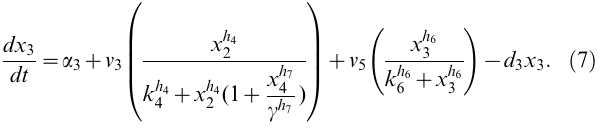
Found at: doi:10.1371/journal.pone.0008083.s002 (0.47 MB TIF) Figure S3 Continuation results for Scenario 2. Continuation results for Scenario 2 using DDE-BIFTOOL software. (A) Two parameters continuation of the Hopf bifurcation on parameters k 2 (Michealis-Menten coefficient of the HO promoter) and h 3 (Hill coefficient of the MET16 promoter). (B) Two parameters contin- uation of the Hopf bifurcation on parameters v 2 (maximal transcriptional rate of the MET16 promoter) and k 6 (Michealis- Menten coefficient of the ASH1 promoter). (C) Two parameters continuation of the Hopf bifurcation on parameters k 6 (Michealis- Menten coefficient of the ASH1 promoter) and h 3 (Hill coefficient of the MET16 promoter). (D) Two parameters continuation of the Hopf bifurcation on parameters h 3 (Hill coefficient of the MET16 promoter) and h 6 (Hill coefficient of the ASH1 promoter). (E) Tunability of the oscillations in terms of amplitude. Amplitude of x 1 (level of the CBF1 gene) continuing the periodic solution on h 3 (Hill coefficient of the MET16 promoter). (F) Tunability of the oscillations in terms of period. Period of x 1 ( CBF1 gene) continuing the periodic solution on h 3 (Hill coefficient of the MET16 promoter). Found at: doi:10.1371/journal.pone.0008083.s003 (0.30 MB TIF) Figure S4 Continuation results for Scenario 3. Continuation results for Scenario 3 using DDE-BIFTOOL software. (A) Two parameters continuation of the Hopf bifurcation on parameters k 2 (Michealis-Menten coefficient of the HO promoter) and h 3 (Hill coefficient of the MET16 promoter). (B) Two parameters continuation of the Hopf bifurcation on parameters v 2 (maximal transcriptional rate of the MET16 promoter) and k 6 (Michealis- Menten coefficient of the ASH1 promoter). (C) Two parameters continuation of the Hopf bifurcation on parameters k 6 (Michealis- Menten coefficient of the ASH1 promoter) and h 3 (Hill coefficient of the MET16 promoter). (D) Two parameters continuation of the Hopf bifurcation on parameters h 3 (Hill coefficient of the MET16 promoter) and h 6 (Hill coefficient of the ASH1 promoter). (E) Tunability of the oscillations in terms of amplitude. Amplitude of x 1 (level of the CBF1 gene) continuing the periodic solution on h 3 (Hill coefficient of the MET16 promoter). (F) Tunability of the oscillations in terms of period. Period of x 1 ( CBF1 gene) continuing the periodic solution on h 6 (Hill coefficient of the ASH1 promoter). Found at: doi:10.1371/journal.pone.0008083.s004 (0.26 MB TIF) Figure S5 Continuation results for Scenario 4. (A) Scenario 4 A. One parameter continuation of the steady state on k 1 (Michealis- Menten coefficient of the HO promoter). Two saddle-node bifurcation points (at (k 1 ; x 1 )= (0.02 0.007) and (k 1 ; x 1 )= (0.14 0.01)) delimitate the bistability region. (B) Scenario 4 A. One parameter continuation of the steady state on h 1 (Hill coefficient of the HO promoter). Two saddle-node bifurcations (at (h 1 ; x 1 )=(2 0.008) and (h 1 ; x 1 )= (40 0.019)) delimitate the bistability region. (C) Scenario 4 A. Two parameters continuation of one saddle- node bifurcation point on v 2 (maximal transcriptional rate of the MET16 promoter) and h 3 (Hill coefficient of the MET16 promoter). The cusp bifurcation occurs at (v 2 ; h 3 )= (0.0005 0.39). (D) Scenario 4 B. One parameter continuation of